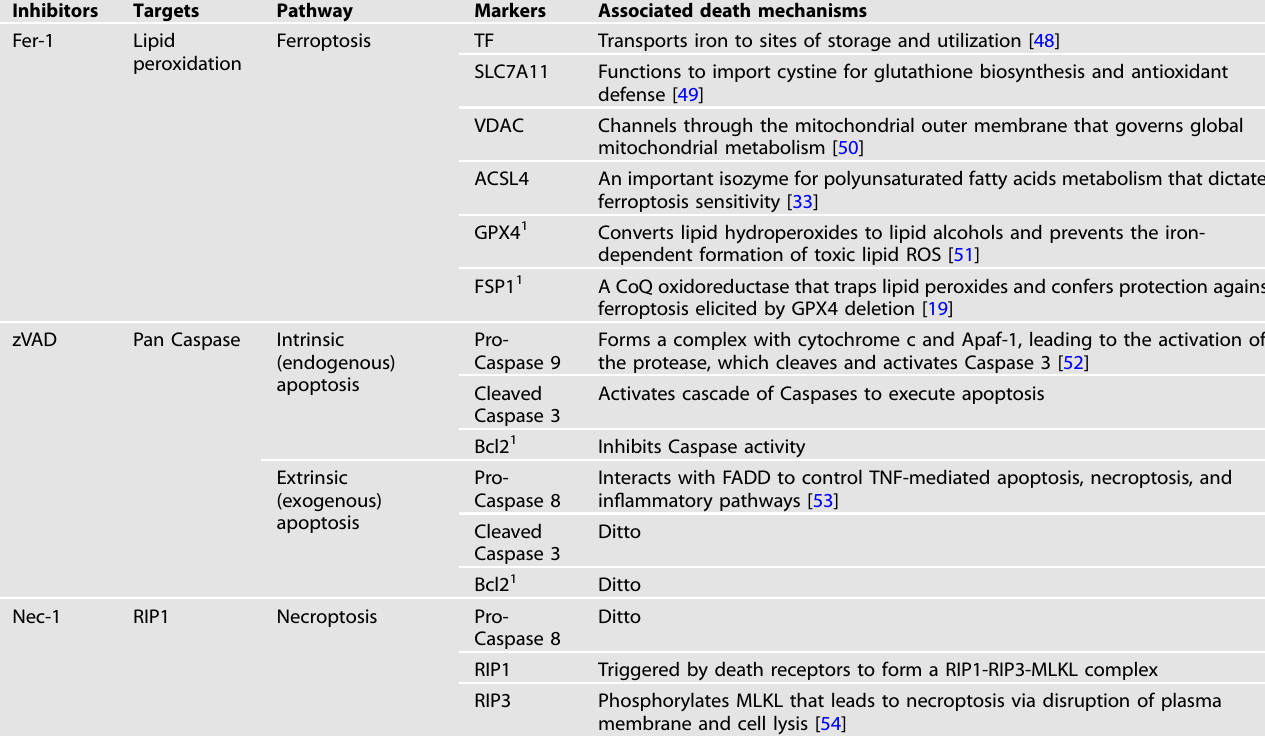
1 Indicates protective genes in the pathways. Fer-1 Ferrostatin-1, zVAD z-VAD-FMK, Nec-1 Necrostatin-1, TF transferrin, SLC7A11 solute carrier family 7 member 11, VDAC voltage-dependent anion